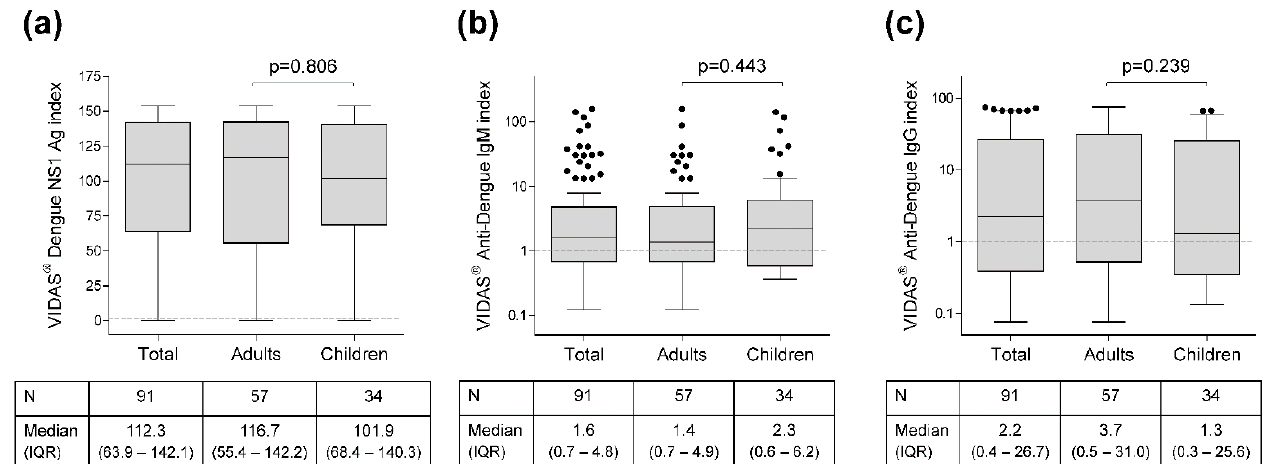
Figure 2. Study distribution of index values generated by the VIDAS ® prototypes VIDAS ® DENGUE NS1 Ag ( a ), VIDAS ® Anti-DENGUE IgM ( b ), and VIDAS ® Anti-DENGUE IgG ( c ). Index values are depicted as Tukey box plots in the total population of patients with acute DENV infection ( N = 91), and as per adults ( N = 57) and children ( N = 34). The grey dashed line shows the positivity cut-off (i = 1.0). VIDAS ® Anti-DENGUE IgM and IgG index values ( b , c ) are shown in log10 scale to better visualize the index distribution. Index median and interquartile range (IQR) is shown below each graph. Differences in index distribution between adults and children were tested with the nonparametric two-tailed Mann–Whitney U -test; the differences were not statistically significant ( p > 0.05 for the three VIDAS ® prototypes).